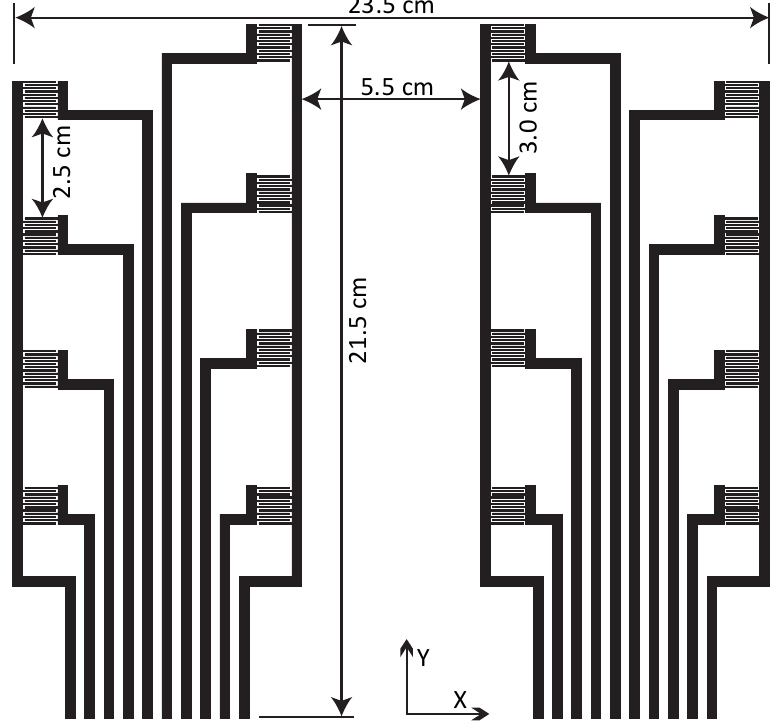
Figure 1. Area of the pressure sensor and placement of sensing elements.